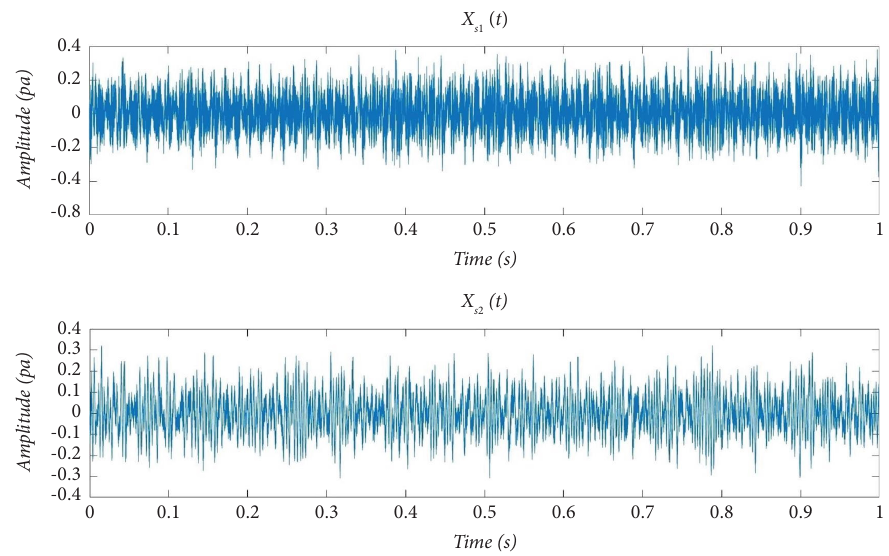
Figure 4: xs 1( t ), xs 2( t ) time domain waveform of CMF.